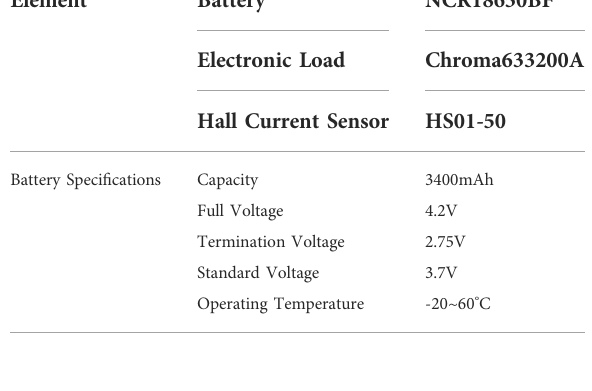
TABLE 2 elements used in the experiment including and battery speci fi cations.